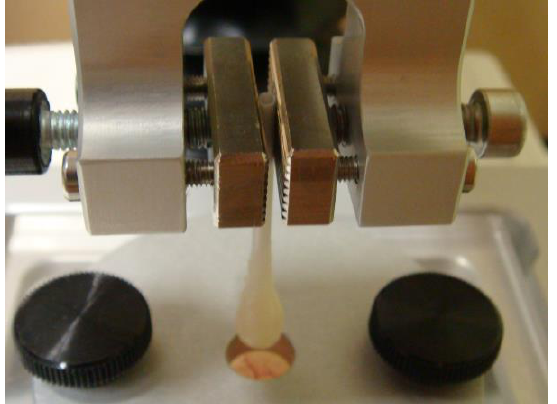
Figure 17. Schematic of serosa-hydrogel adhesion